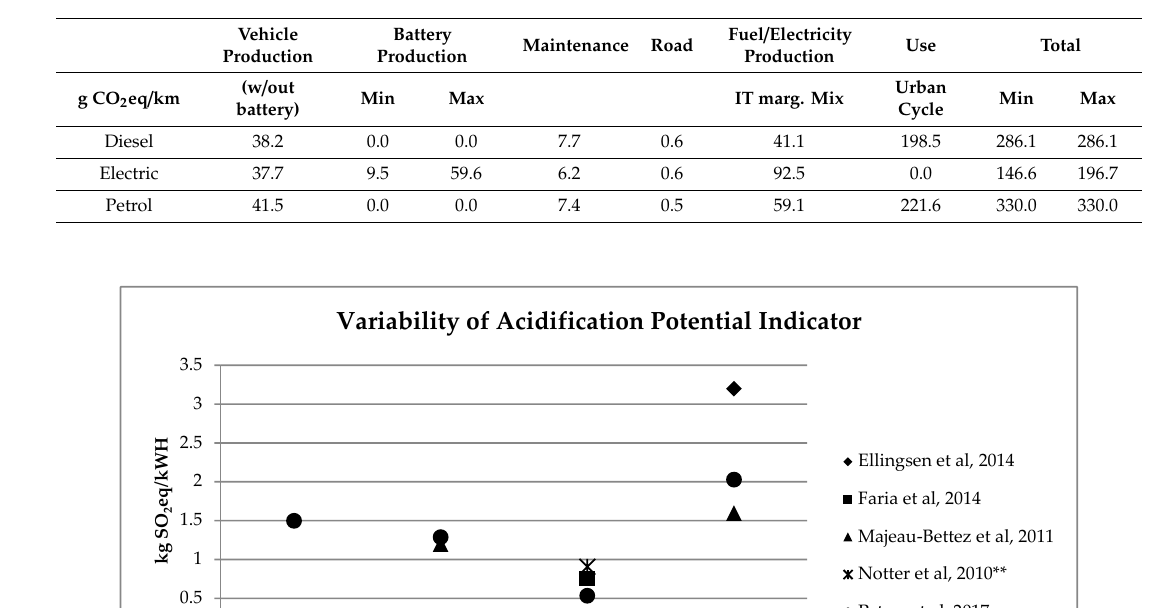
Table 3. E ff ects of the variability of CO 2 eq emission per kWh of battery on the life cycle comparison among a middle size electric, diesel and petrol car. Battery CO 2 eq emission per km derives from Figure 2 , considering 40 kWh of capacity and 210,000 km of life. CO 2 eq emission per km of remaining life cycle phases are taken from reference [1].